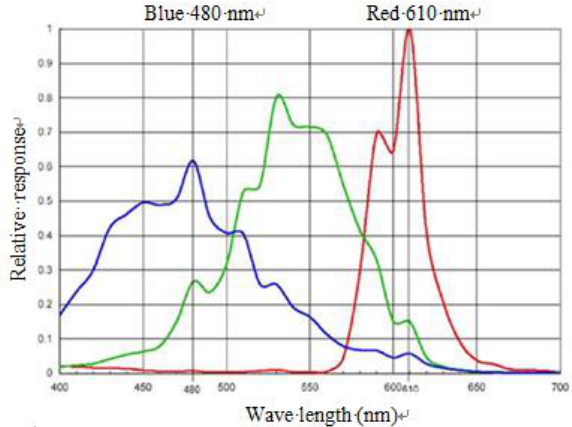
Fig. 6. Spectral response of digital camera between wave length (nm) and relative response